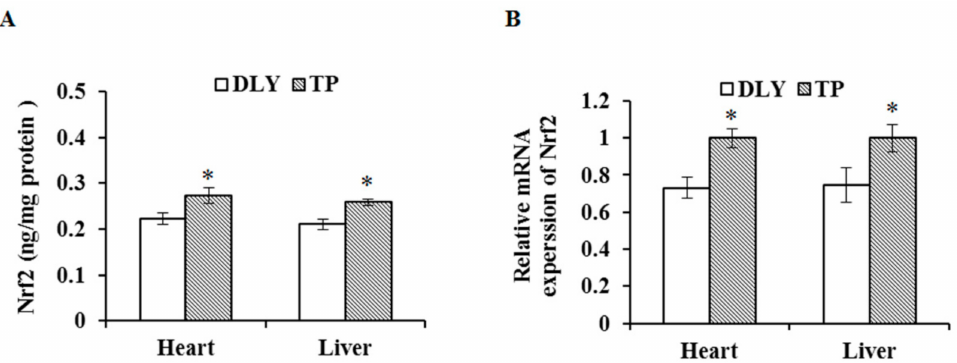
Figure 6. Effects of the plateau environment on protein ( A ) and mRNA ( B ) expression levels of Nrf2 in heart and liver of TPs and DLY pigs ( n = 12). * Significant difference ( p < 0.05). Nrf2 = nuclear factor erythroid 2-related factor